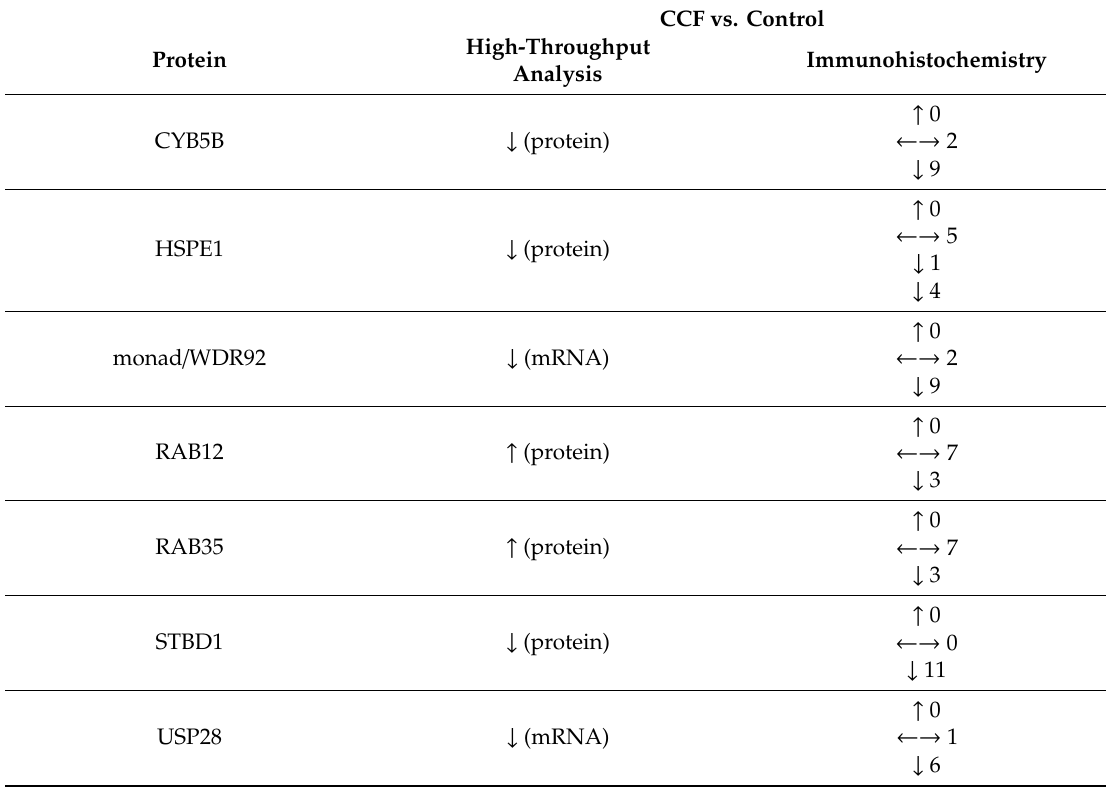
Table 3. Validation of protein expression as predicted by high-throughput analysis (see Tables 1 and 2 for fold changes) in CCF by immunohistochemical analysis. Arrows indicate higher ( ↑ ), lower ( ↓ ), and unchanged ( ←→ ) expression in CCF compared to unaltered liver tissue. Numbers in the immunohistochemistry column denote the number of individual patient samples